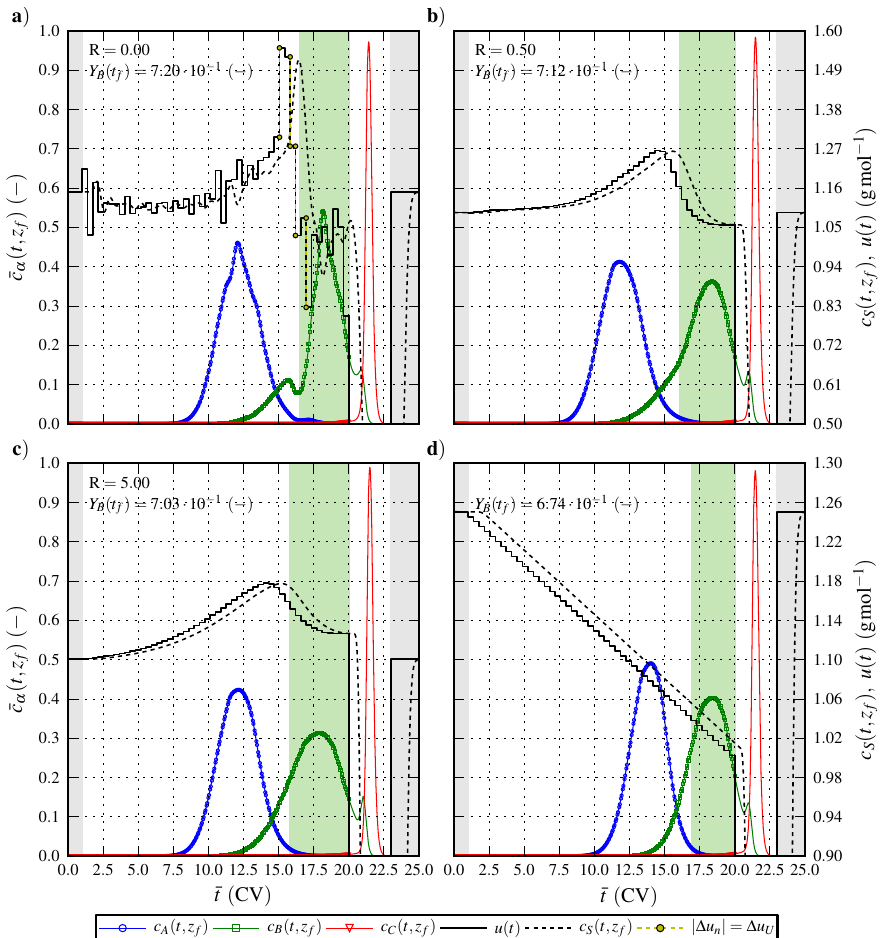
α A , B , C is ∀ ∈ { } ) and 10 − 1 ( × −